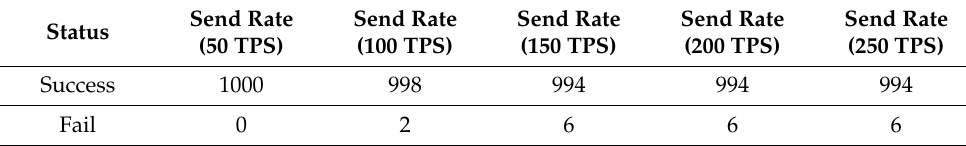
Table 6. Transaction status of 1000 writing in the private transaction.